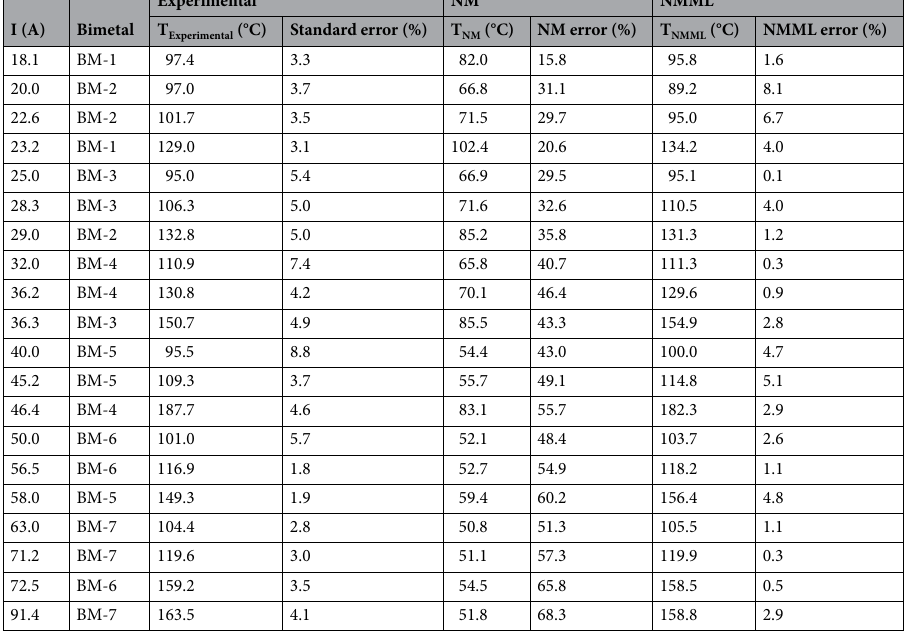
Table 7. The standard error of the experimental results, the calculation error of the NM and NMML